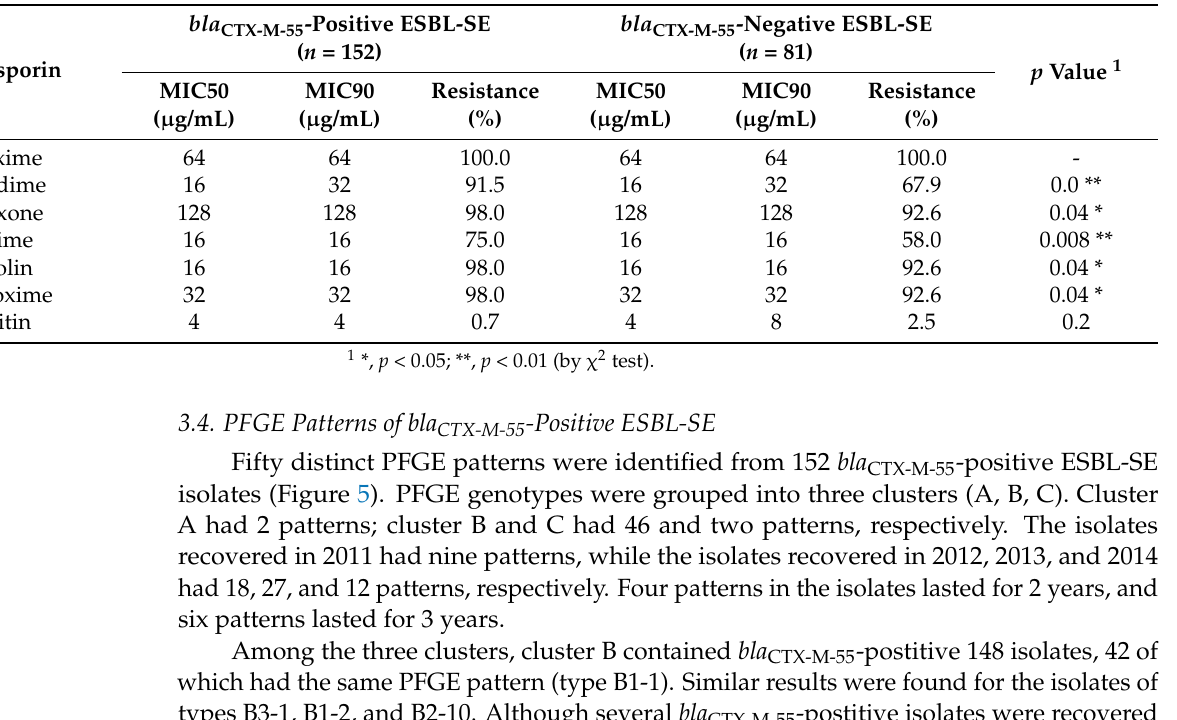
Table 3. The minimum inhibitory concentrations (MICs) of cephalosporins for clinical ESBL-producing S. Enteritidis (ESBL-SE) isolates ( n =